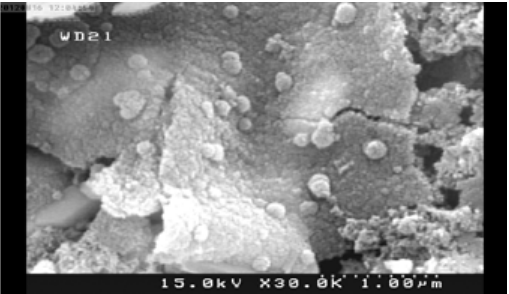
Fig. 4. SEM photograph [Ni(cd5Clsalen)] (2) nano-particles prepared by hydrothermal method.